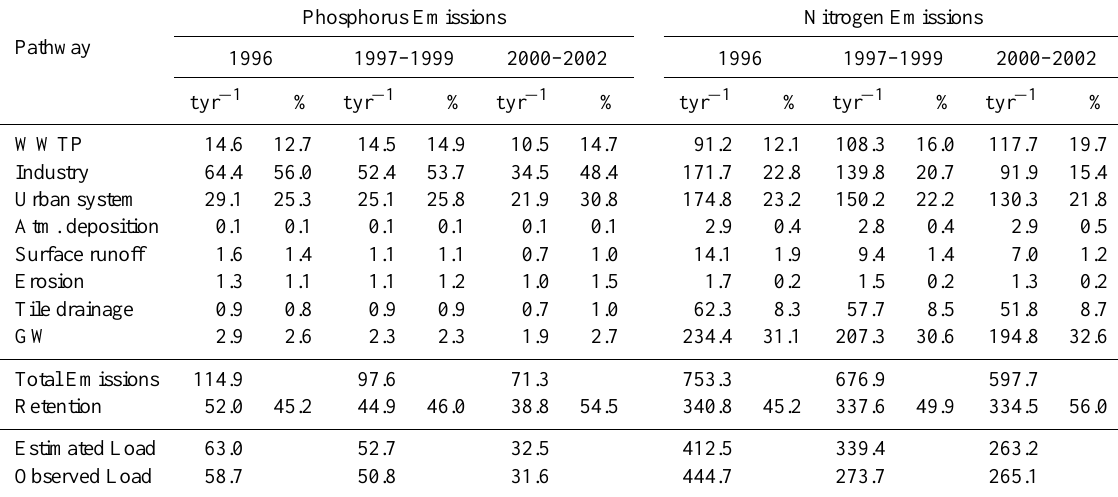
Table 3. Contribution of the different sources to the emissions of phosphorus and nitrogen into the river basin in tonnesyr − 1 and as a percentage of the total emissions in the basin. Two periods, 1997–1999 and 2000–2002, are used to show changes in the estimation of nutrient emissions based on the year 1996, the first reliable year of model